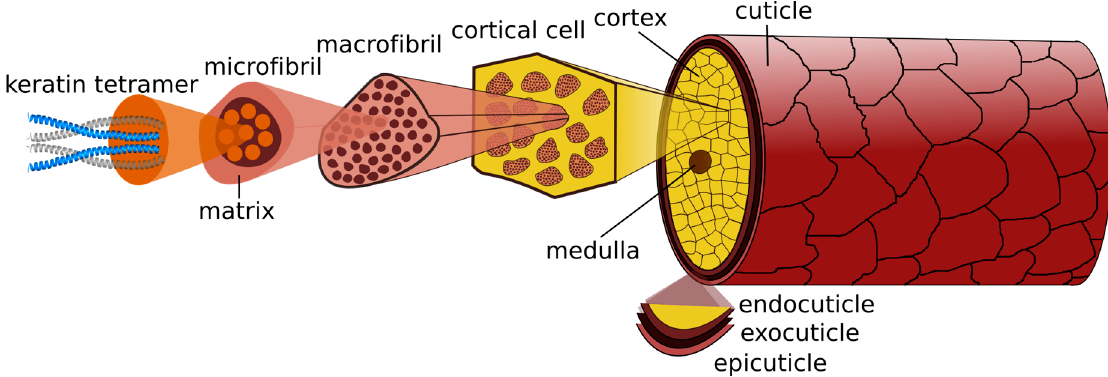
Figure 4. Schematic cross-section of a hair fiber.